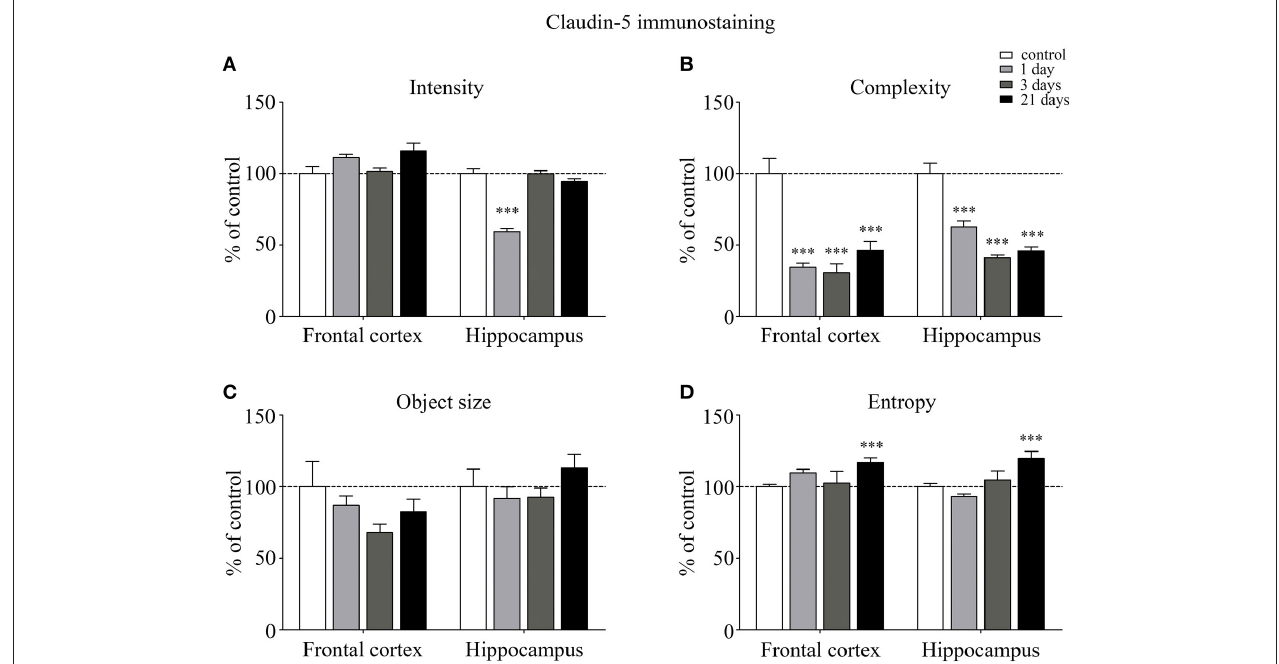
FIGURE 3 | Analysis of claudin-5 immunofluorescence pattern in the frontal cortex and hippocampus of rats following restraint stress. Graphs represent quantification of the intensity (A) , complexity (B) , mean object size (C) , and entropy (D) of immunostained structures. Results are expressed as percentages of the unstressed control group. Values for each group are means ± SEM. Data were analyzed by One-way ANOVA followed by a Bonferroni post hoc test. *** p < 0.001 , significant differences as compared to the unstressed control group.